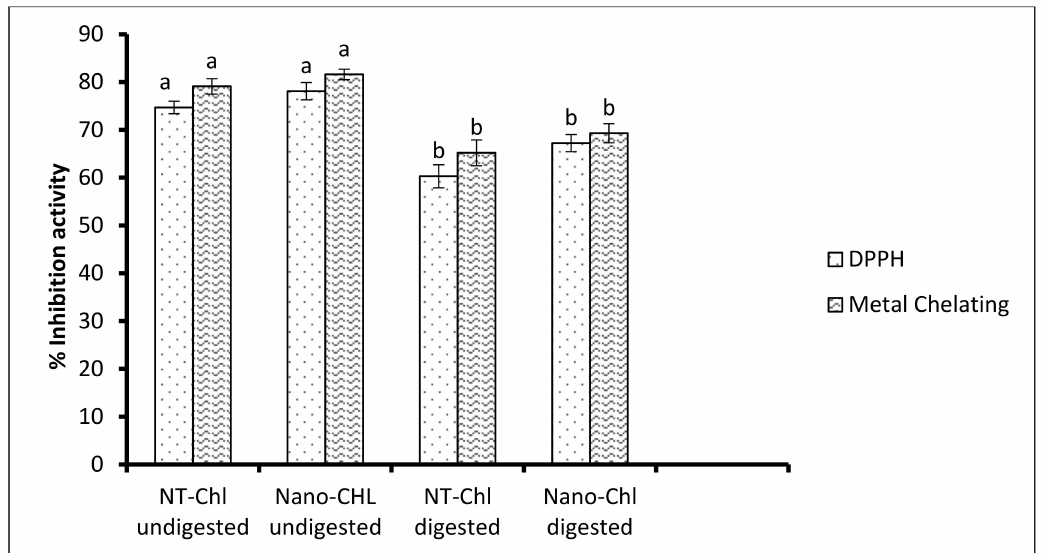
Figure 6. Antioxidant activity of the NT-Chl and Nano-Chl. Bars represent standard deviation (n = 3). Different letters on the bars representing same antioxidant assay and encapsulation methods indicate significant differences ( p < 0.05). For caption, see Figure